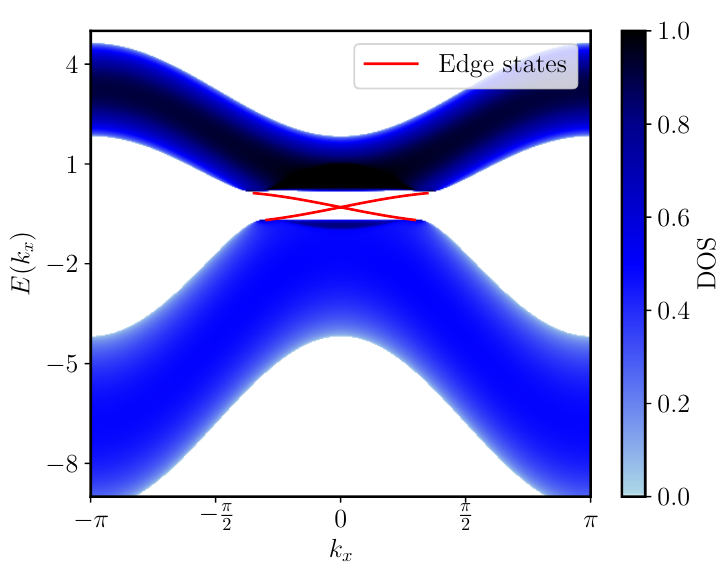
Figure 10: Color map of the density of states in the quantum spin Hall effect (blue) and corresponding edge states (red). The parameters have been fixed so that the model is in the topologically non-trivial insulating phase, A = 0.5, B = 1, C = 0, D = 0.3, M = − 1.